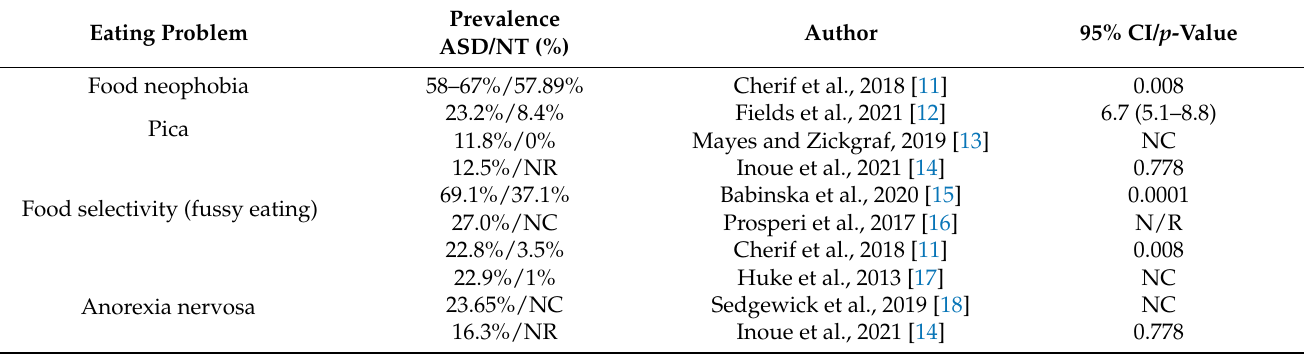
Table 1. Most common eating problems in NT vs. ASD